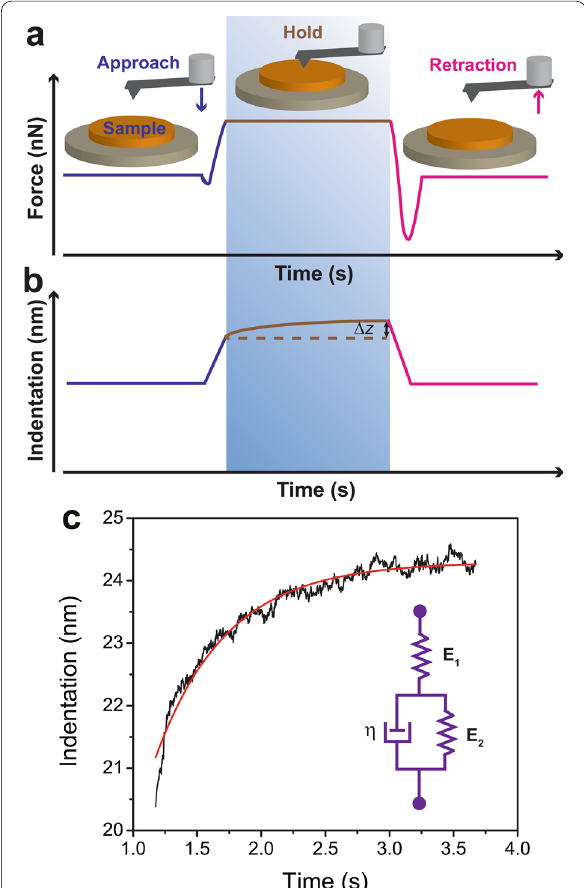
Fig. 4 Creep compliance measurement on a neat LDPE region of the PS/LDPE sample. The working principle of AFM creep experiment was illustrated in panel a . Initially, the AFM tip was brought into contact with sample surface till it reached the predefined force setpoint. The tip was then held onto the sample for a certain time period, during which the force was kept constant. Following that, the tip was retracted. In the hold segment, the AFM recorded the change in Z motion (panel b ). The change in indentation depth as a function of time could be fitted with Voigt version of SLS model using Eq. (13). A representative creep curve was shown in panel c . The black curve was the data, while the red solid line was the fitting curve. The inset indicated the Voigt version of SLS model, featuring a spring ( E 1 ) in series with a spring ( E 2 )-dashpot ( η ) Voigt element in